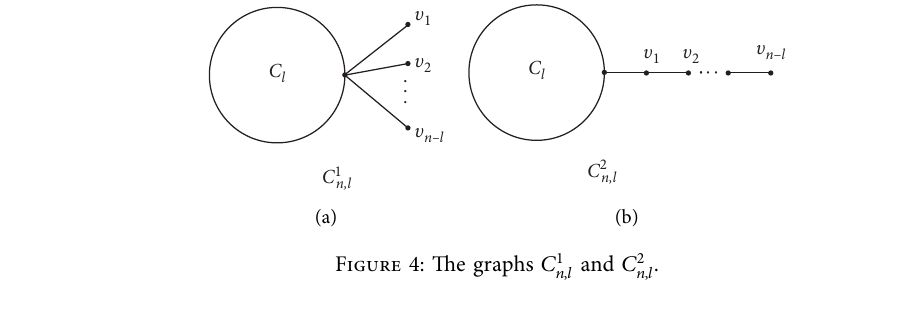
and C 2 . n,l n,l